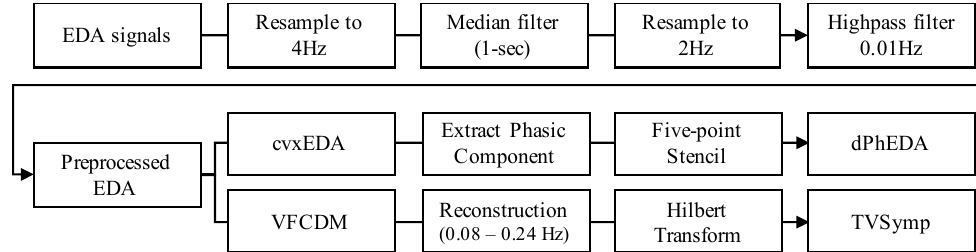
Figure 1. Flow chart of TVSymp and MTVSymp calculation. EDA: electrodermal activity, cvxEDA: convex EDA optimization method, VFCDM: variable frequency complex demodulation.